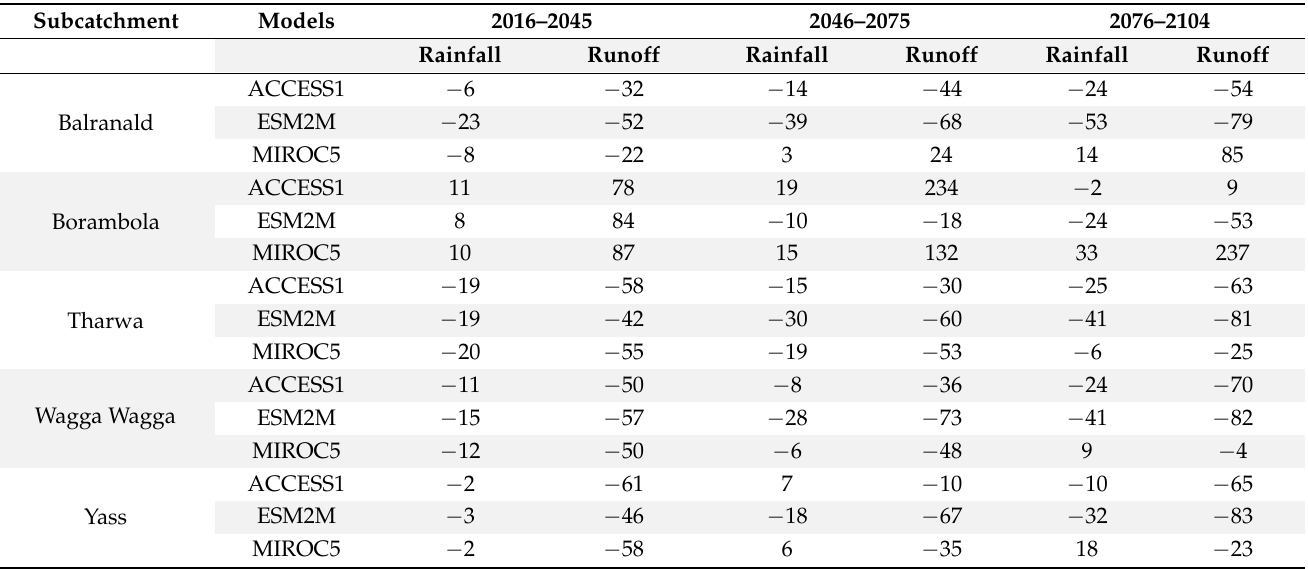
Table 10. Annual change (%) of runoff between simulated (using future climate data) comparing to the historical for RCP 8.5 at sub-catchments of Murrumbidgee River basin.